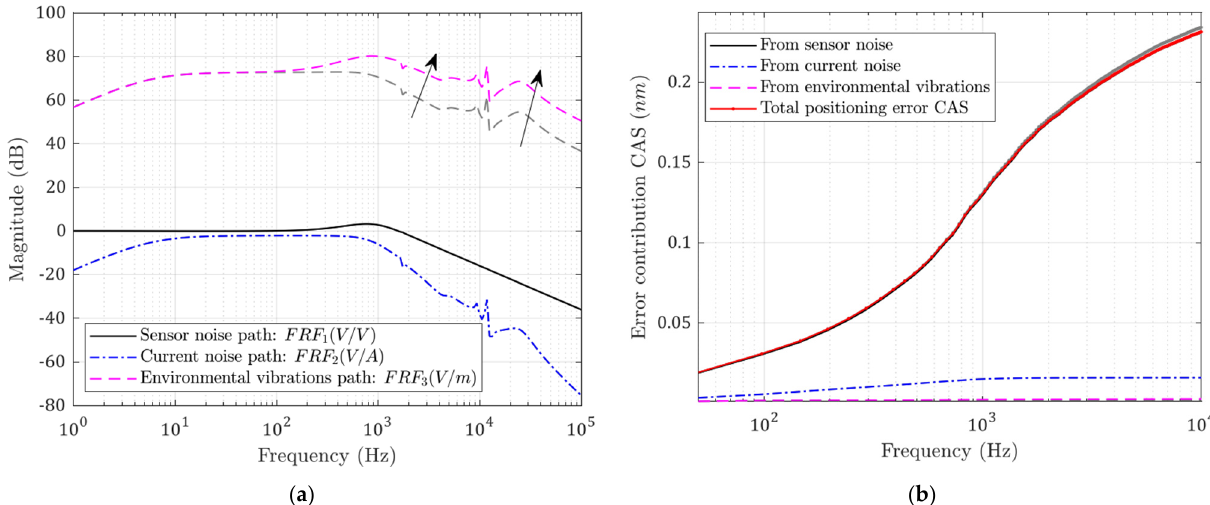
Figure 13. ( a ) Noise transfer functions; ( b ) CAS plots for each error source. Performance with increased flexure damping 𝑐 (cid:2870) (grey: before; colored: after)